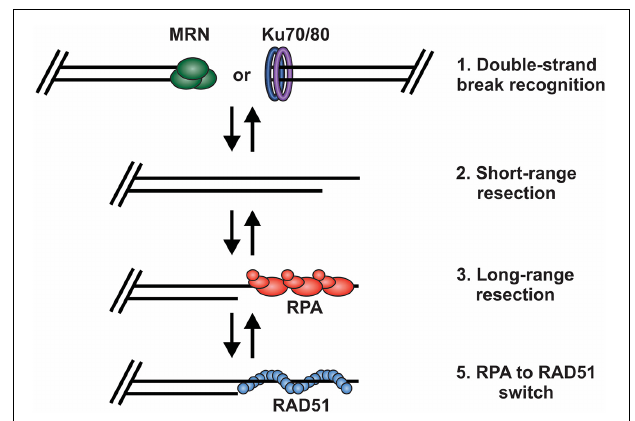
FIGURE 3 | Key decision points in the repair of DSBs by HR. (1) The DNA ends are bound by either MRN or the Ku70/80 heterodimer. Binding and retention of MRN will shift repair toward HR and the binding of Ku shifts repair toward to NHEJ. (2) Short range resection by MRN. (3) Long-range resection of the DNA and RPA binding. (4) RPA is exchanged for RAD51, which facilitates strand invasion, DNA synthesis and HR repair.